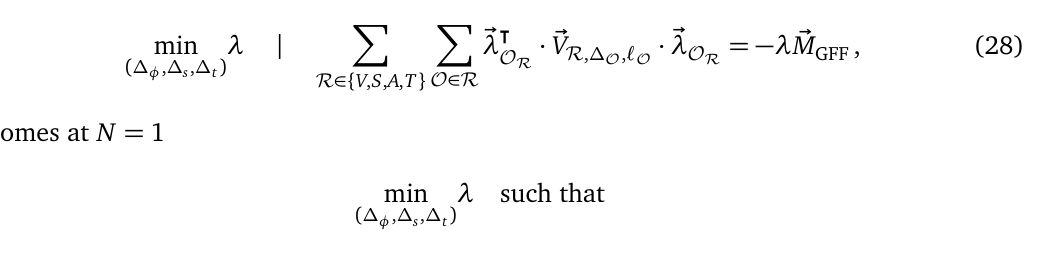
and γ to large values, we see that this run s t